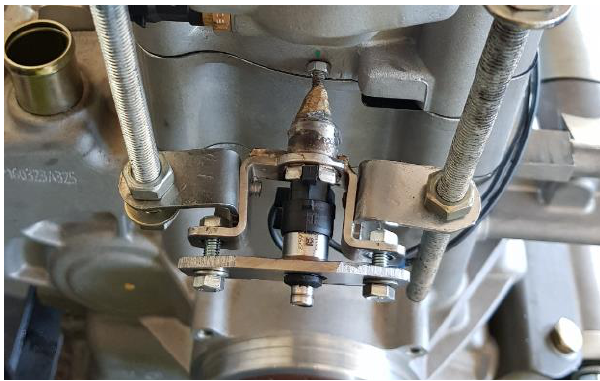
Fig. 9. Cylinder head with extraction channel and installed valve